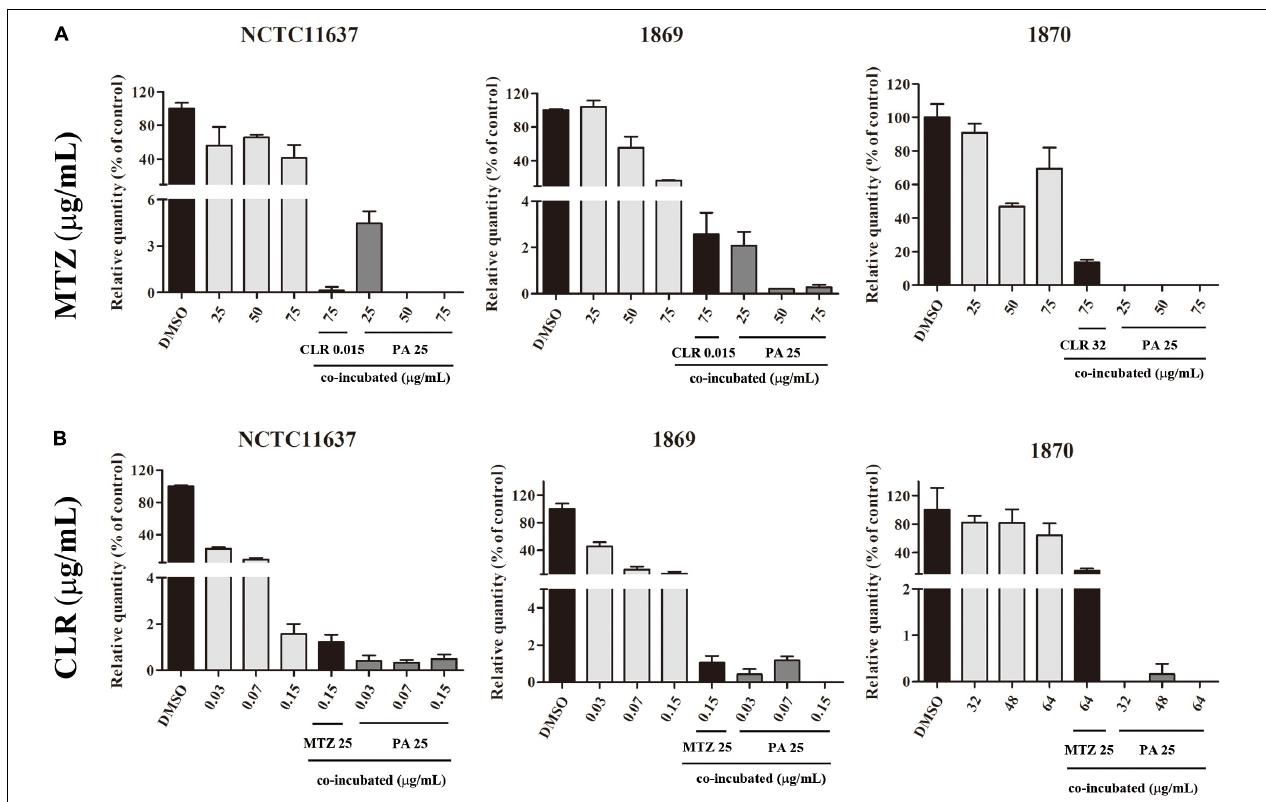
FIGURE 5 | Combined effect of PA and antibiotics against intracellular H. pylori . (A) Killing ability of MTZ alone and in combination with PA (25 µ g/ml) against the intracellular H. pylori standard strain NCTC11637 and drug-resistant strains Hp1869 and Hp1870 ( n = 3). (B) Killing ability of CLR alone and in combination with PA (25 µ g/ml) against intracellular the H. pylori standard strain NCTC11637 and drug-resistant strains Hp1869 and Hp1870 ( n = 3). Compared with the control group, a 99% decrease in the intracellular strain viability was defined as an effective